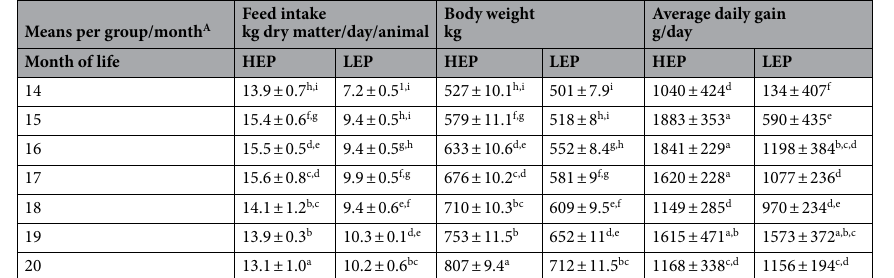
Table 3. Feed intake, body weight and average daily gain during experimental period. A Means ± SD; a,b,c,d,e,f,g,h,i levels not connected by the same letter are significantly different (P < 0.05). Effect of time P < 0.001, group P < 0.001, time × group P < 0.001; with the exception of body weight: effect of time × group P < 0.01.